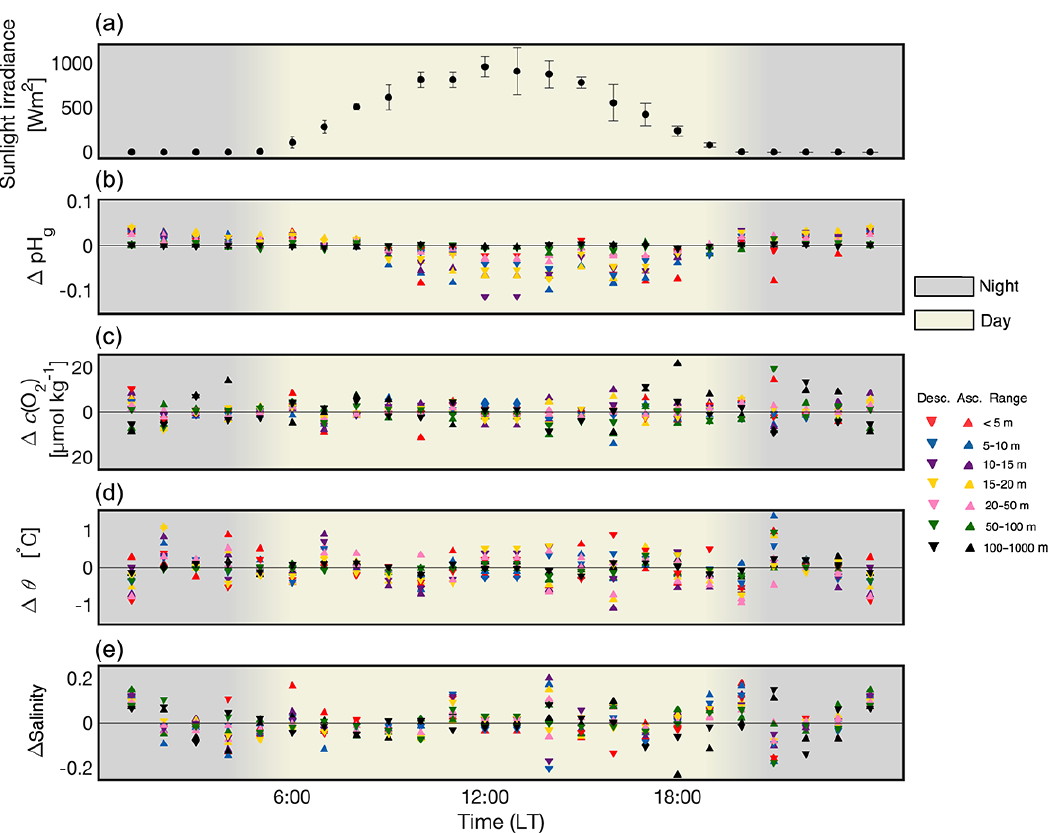
Figure 8. (a) Solar irradiance measured using a pyranometer on meteorological buoy M1 (Fig. 1). (b) Glider-retrieved pH (pH g ), (c) dissolved oxygen concentrations ( c (O 2 )), (d) potential temperature ( θ ), and (e) salinity average anomalies (calculated by subtracting the all-time mean from the hourly means within a given depth interval) for each hour of the day in local time (LT) for five near-surface depth ranges: < 5m, 5–10, 10–15, 15–20, and 20–50m, as well as two deeper depth ranges of 50–100 and 100–1000m for both ascending (upward triangle) and descending (downward triangle) dive profiles. The grey shaded area represents the nighttime, whilst the lightly shaded area represents the